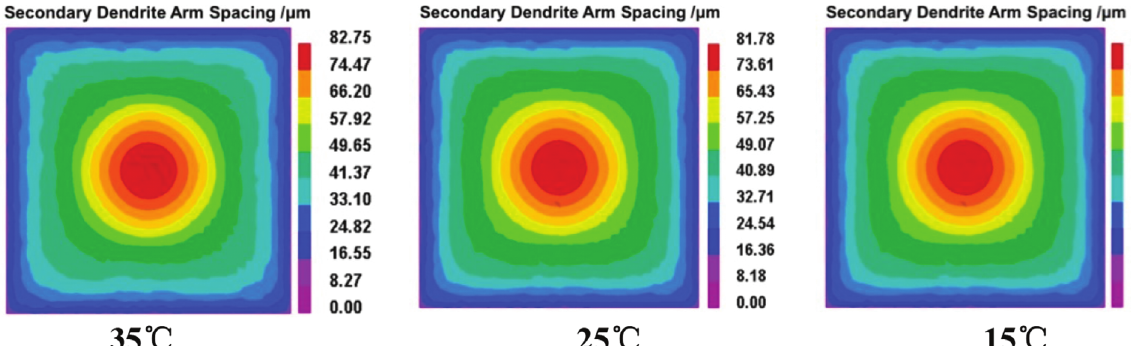
Figure 4: Simulated results of SDAS at different superheat.